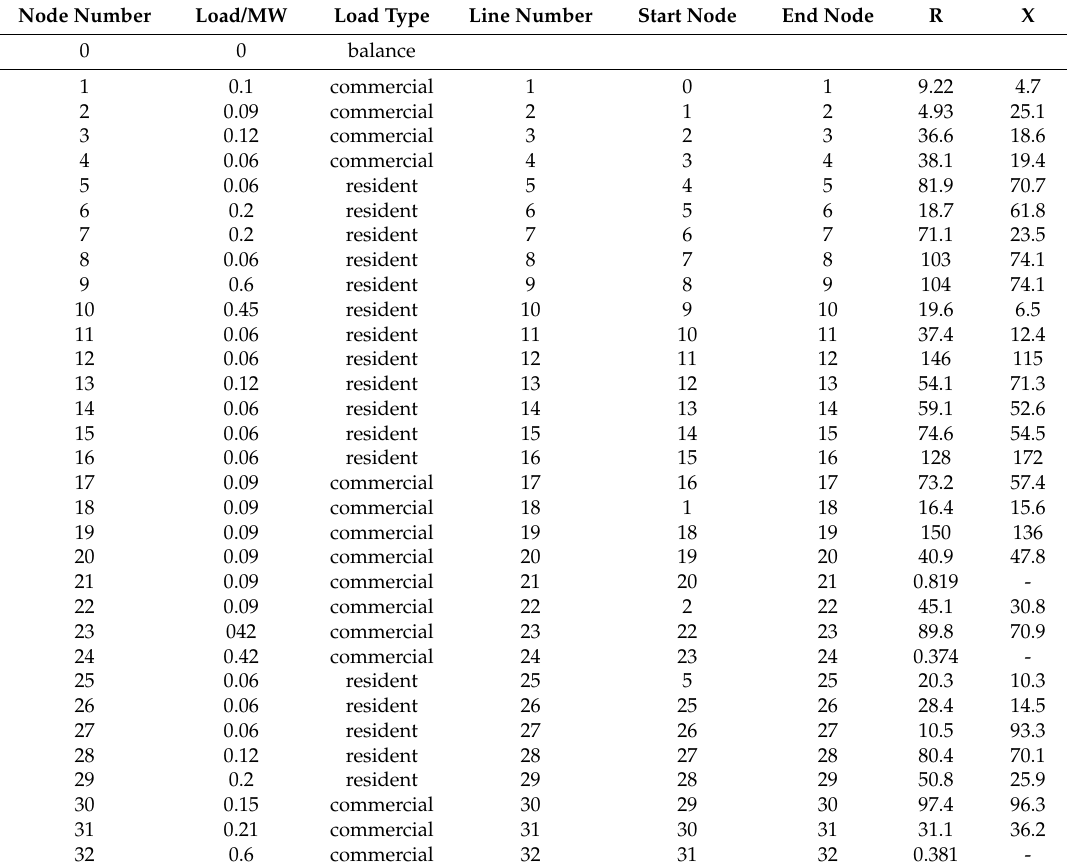
Table 1. Node and line